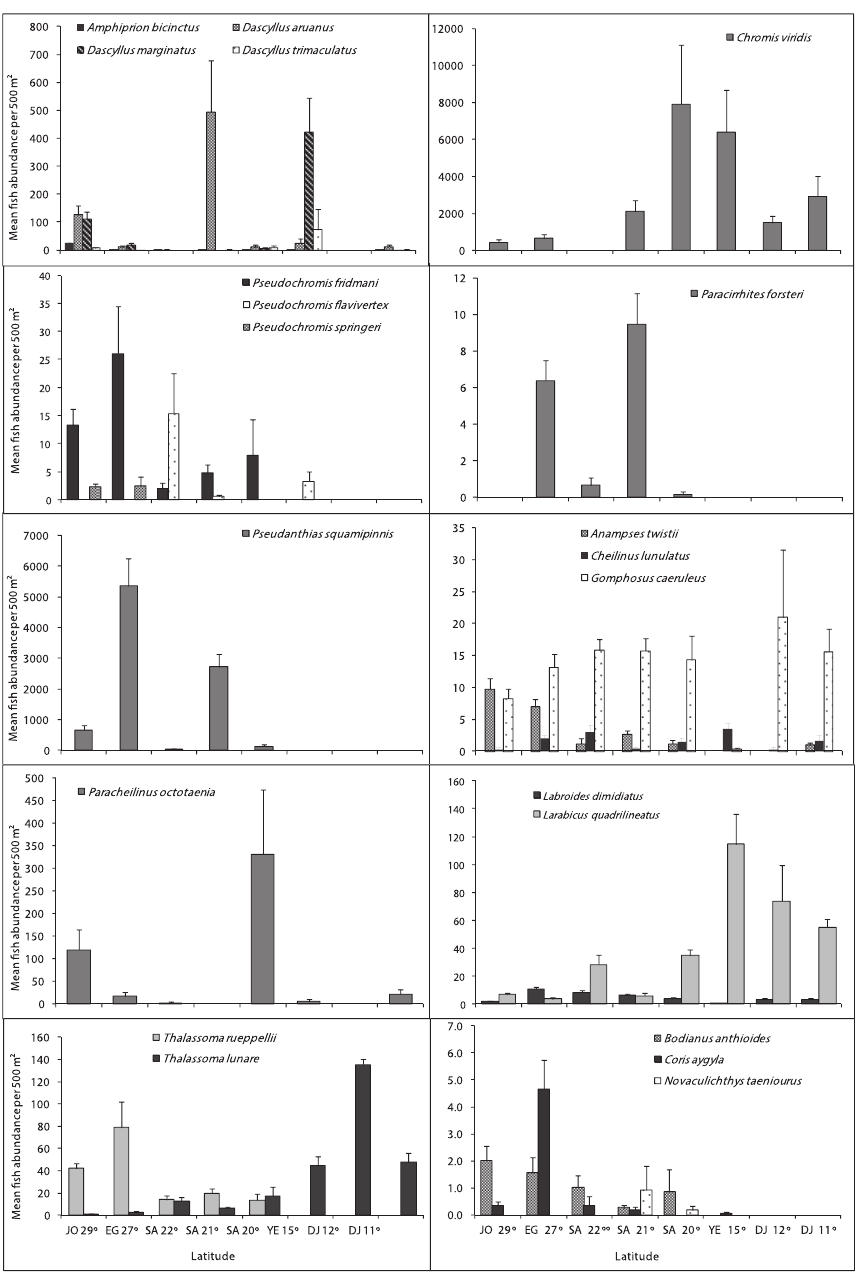
Figure 5. Differences in mean fish abundance per 500 m² transect according to latitudinal distribution for the fish species belonging mainly to families: Pomacentridae ( A. bicinctus, D. aruanus, D. marginatus, D. trimaculatus , and C. viridis ), Pseudochromidae ( P. fridmani, P. flavivertex and P. springeri ), Cirrhitidae ( P. forsteri ), Serranidae ( P. squamipinnis ), and Labridae ( A. twistii, C. lunulatus, G. caeruleus, P. octotaenia, L. dimidiatus, L. qudrilineatus, T. rueppellii, T. lunare, B. anthioides , C. aygula and N. taeniourus